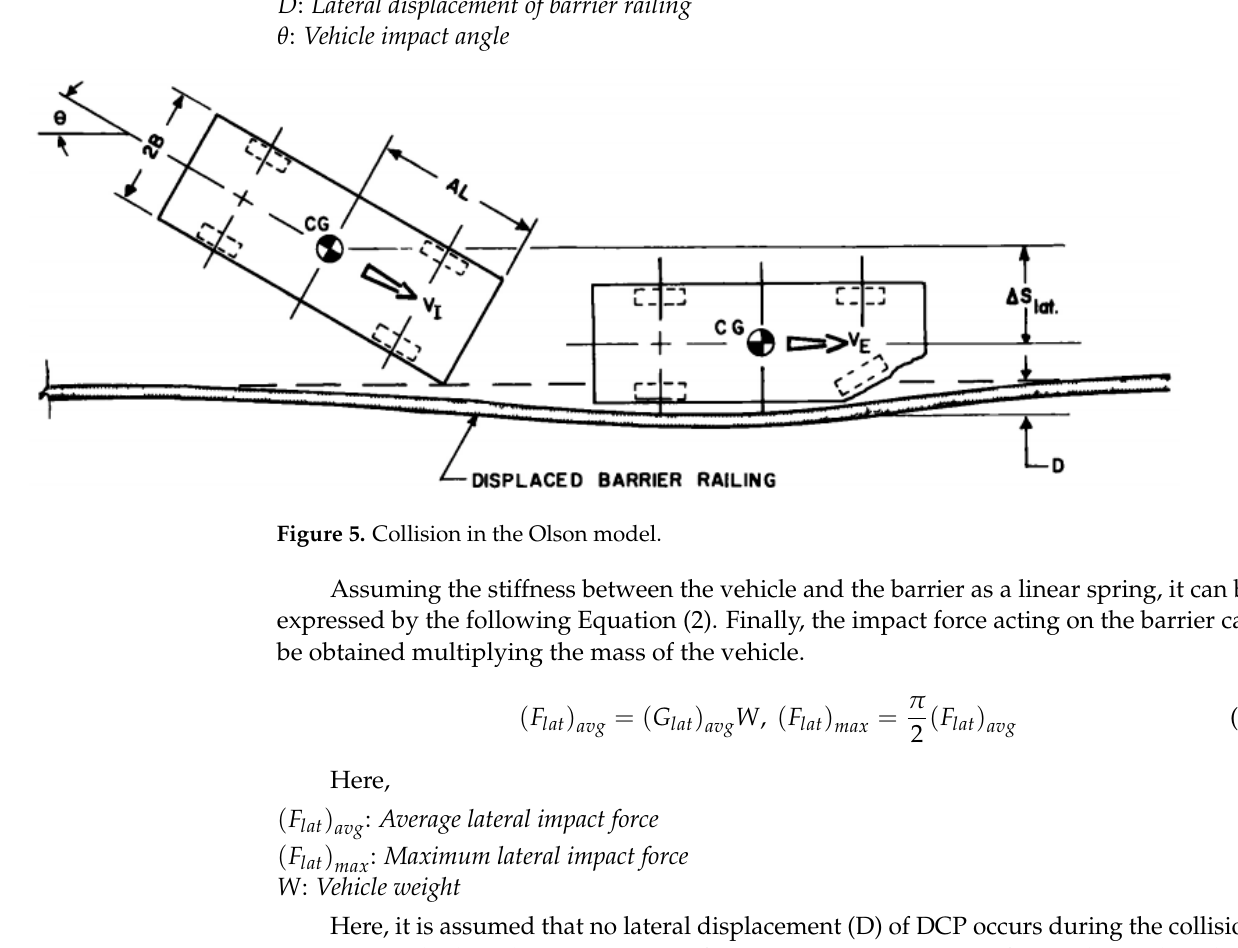
Figure 5. Collision in the Olson model.